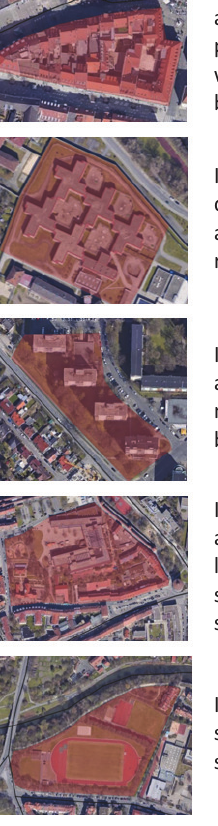
Figure 6. Block typology